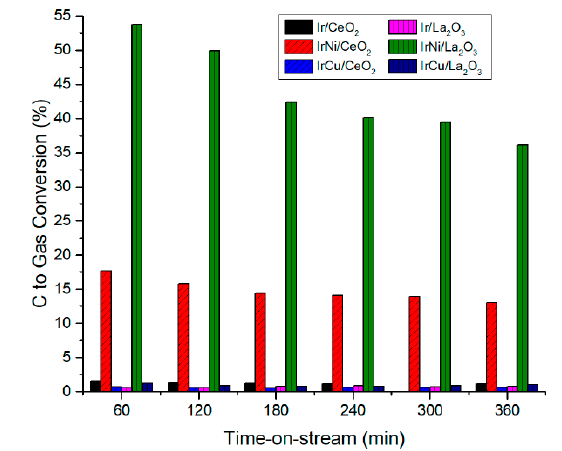
Figure 19. Carbon-to-gas conversion (%) as a function of the time-on-stream (min) stability test carried out at 270 °C and 58 bar [236].